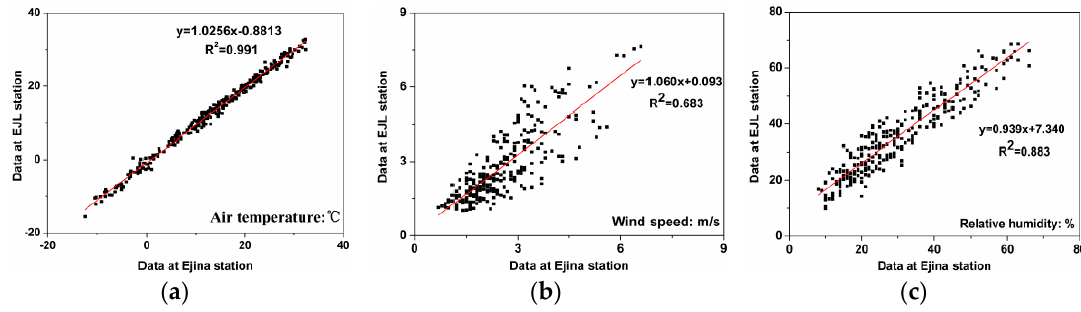
Figure 6. Correlativity of synoptic data between EJL and Ejina station. ( a ) T a ; ( b ) u ; ( c ) RH .